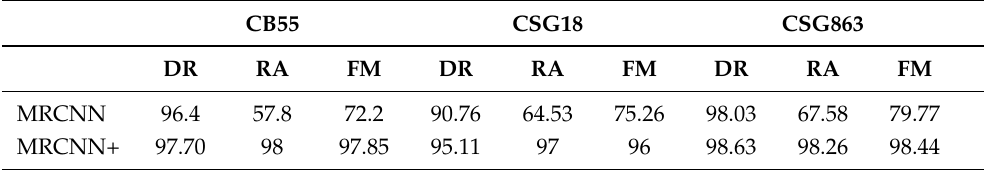
Table 2. Results of the proposed method on the Diva dataset.